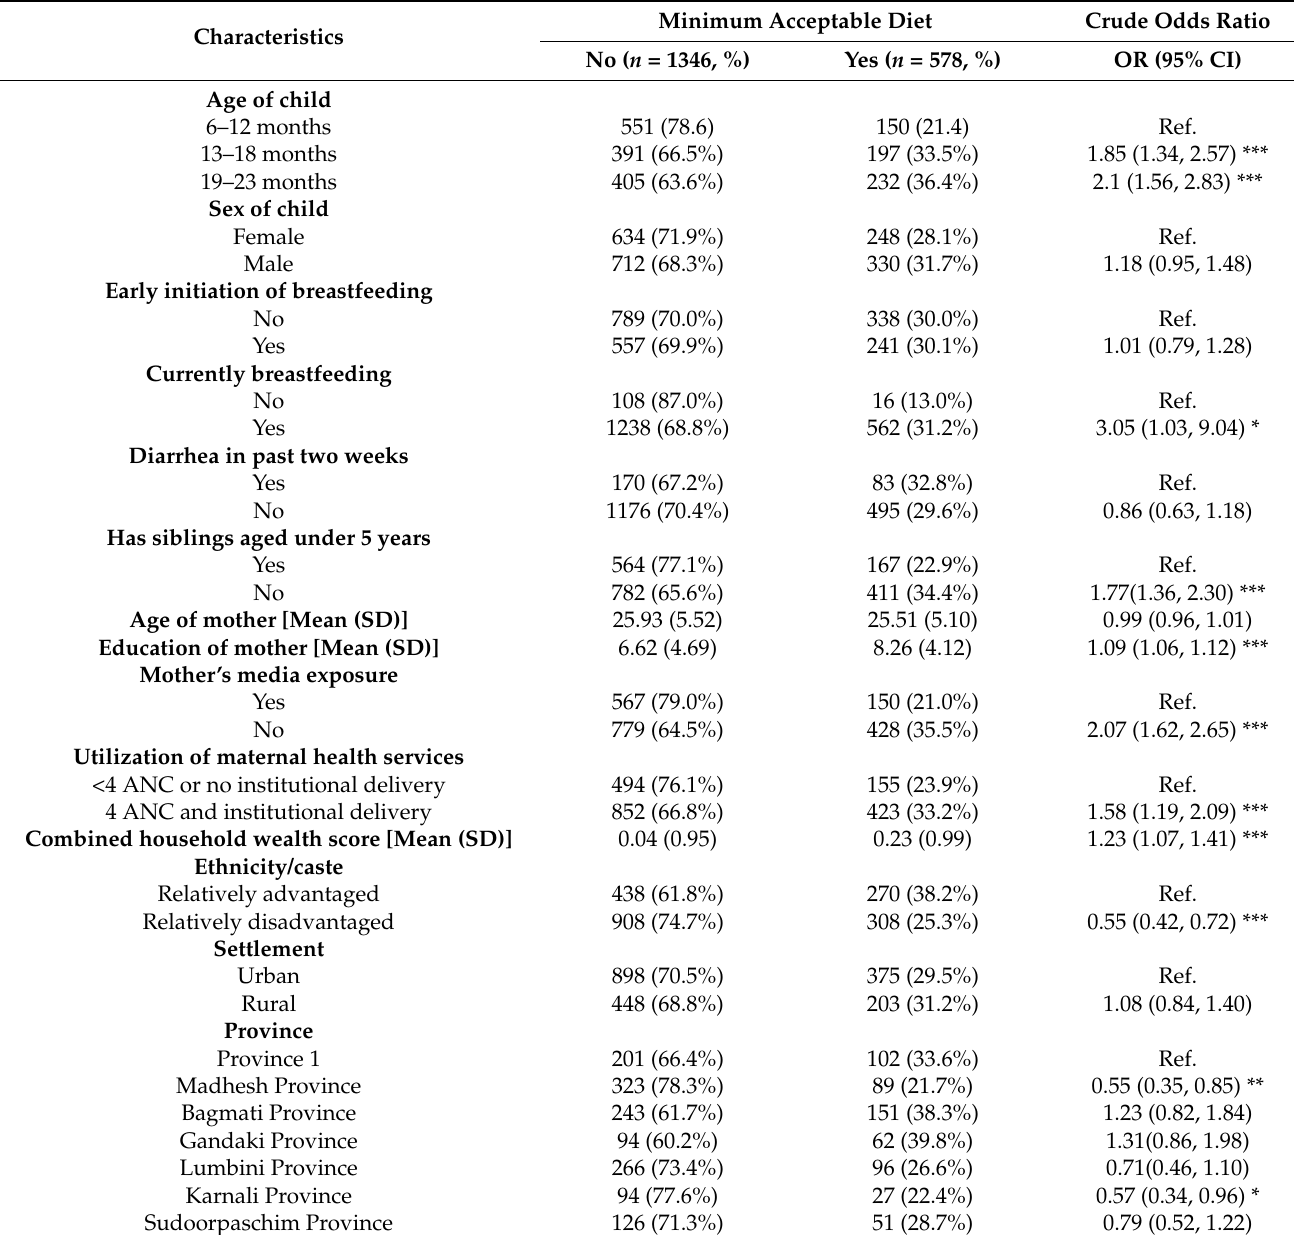
Table 3. Association between minimum acceptable diet and child, maternal, household, and area factors among children aged 6–23 months in